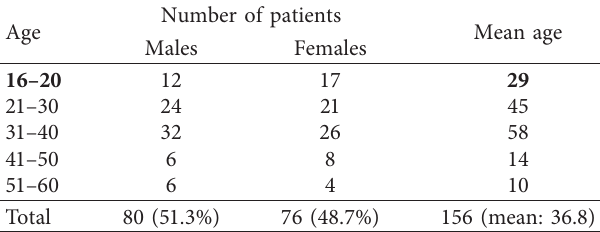
Table 2: Age distribution of the patients included in the